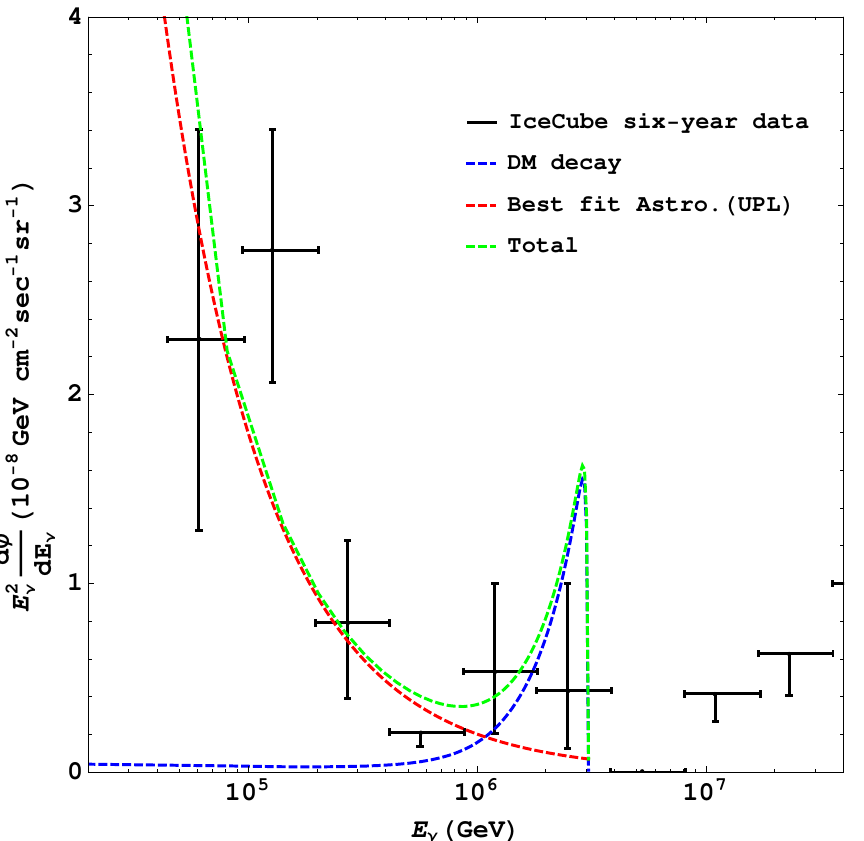
Figure 5 . This (cid:12)gure shows the total predicted terrestrial neutrino (cid:13)ux coming from both sneutrino decays as well as the nominal UPL astrophysical background. The black data points represent the observed neutrino (cid:13)ux which is inferred from IceCube data [15]. We can see that for our benchmark values m ~ = 6 : 5 PeV, m N = 8 PeV and m = 1 : 5 PeV and (cid:28) ~ (cid:24) 10 24 sec, the predicted total 3 = 2 N 1 N 1 neutrino (cid:13)ux closely matches that seen by IceCube, and in particular the PeV events are well accounted for by the sneutrino